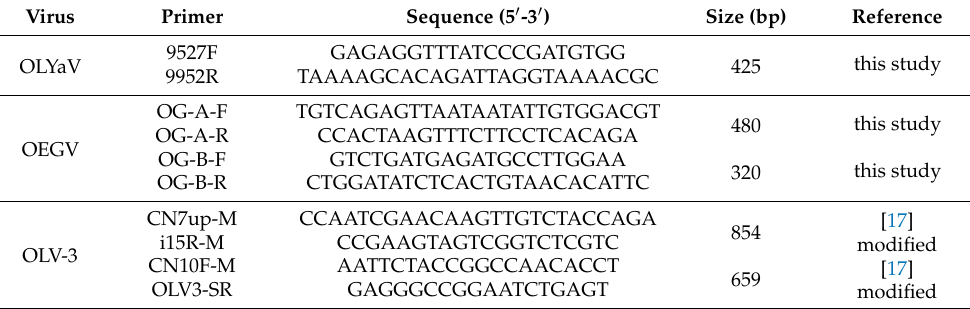
Table 1. Primers used for RT-PCR detection of OLYaV, OEGV, and OLV-3.